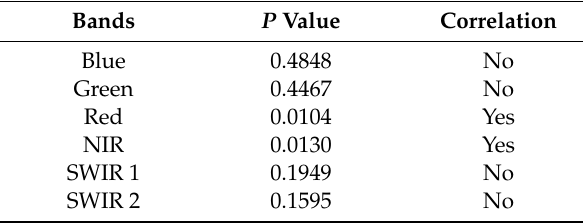
Table 5. Correlation between Decimal Year and BRDF Corrected band adjusted combined Mean TOA Reflectance of Libya 4.